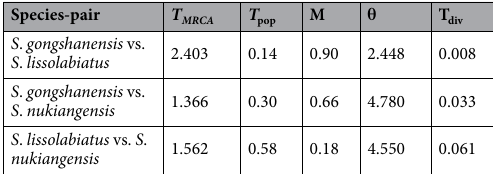
Table 5. Gene flow and estimates of divergence times (in Ma) between species-pairs inferred from MDIV analyses. T MRCA and T pop are measured in units of 2 N e θ ; θ = 2 N e μ , and μ is the mutation rate per sequence per generation. M and T div indicate migration rates (2NM) and divergence times between species-pairs,